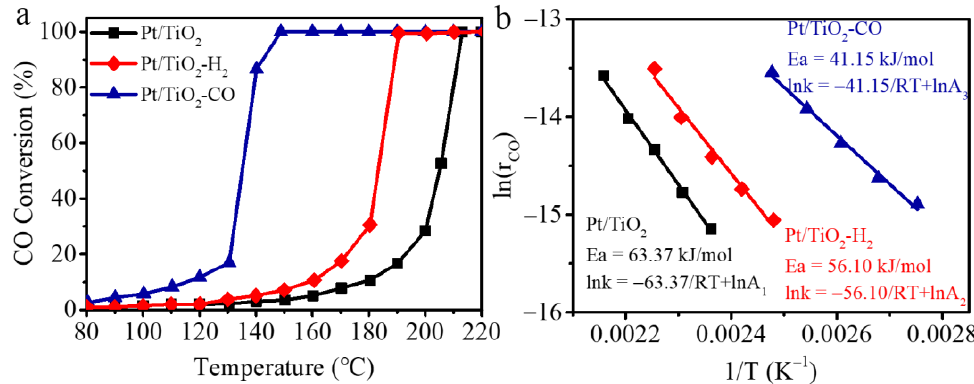
Figure 4. ( a ) CO conversion as a function of reaction temperatures, and ( b ) apparent activation energy (E a ) calculated by the Arrhenius equation of Pt/TiO 2 , Pt/TiO 2 -H 2 , and Pt/TiO 2 -CO catalysts (R = 8.314 × 10 − 3 kJ/(mol · K)). (Note: 2.5 g catalyst, 0.7 vol.% CO, 16 vol.%O 2 in N 2 , GHSV is